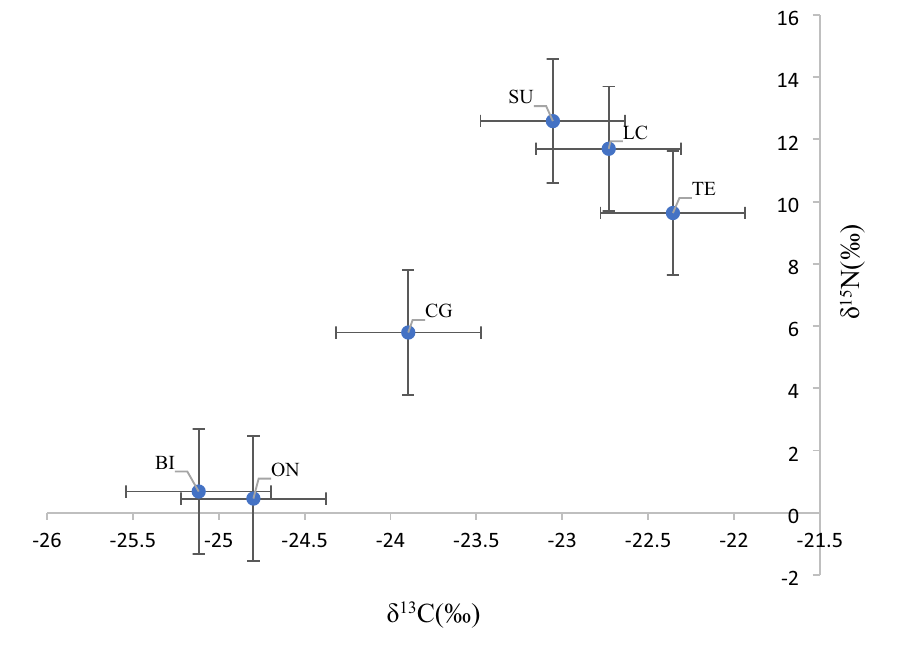
Fig. 4 Trophic levels of bird and fish species sampled from Lake Hawassa,